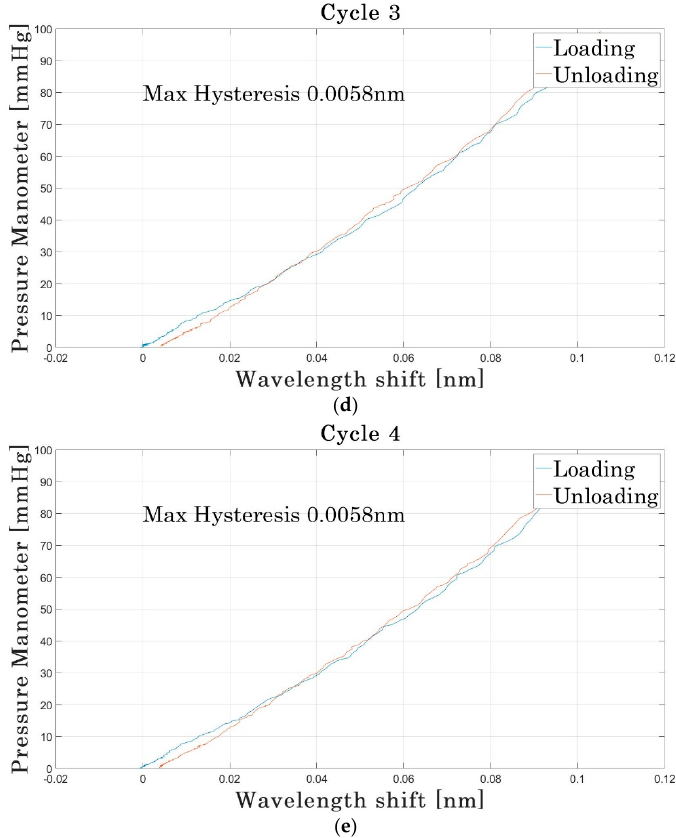
Figure 9. ( a ) Typical results: comparison of wavelength shift produced by the sensor to the pressure from a manometer, taken on a rigid cylindrical tube and controlled by a blood pressure cuff (using the experimental set up in Figure 4). ( b – e ) Pressure against wavelength shift for four loading and unloading cycles.